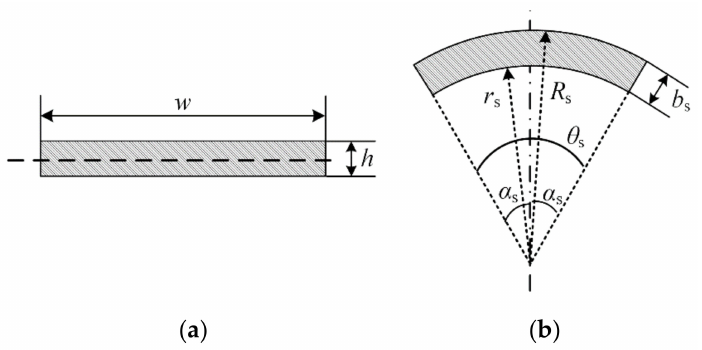
Figure 14. Calculation of section flexural coefficient diagram: ( a ) The metal sheet’s cross-section when it is bent; ( b ) The metal sheet’s cross-section when it is